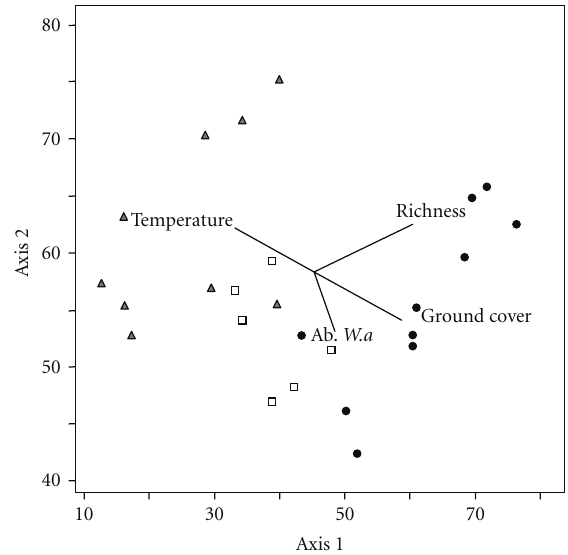
Figure 5: Canonical correspondence analysis (CCA) of the com- position of ants in three habitats ( (cid:2) : Forest; (cid:2) : Pastures; (cid:3) : Cane fields). The lines show the direction and strength of the relationship of the environmental and biotic variables with respect to the structure of the ant assemblage per